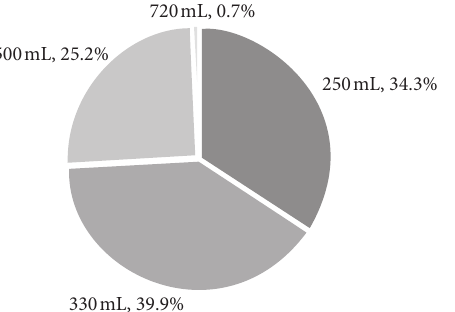
Figure 1: Proportion of energy drink consumers ingesting a given volume of energy drink at one